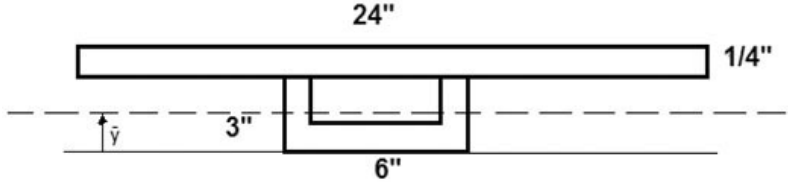
Figure 12. The cross section of an equivalent stiffener or